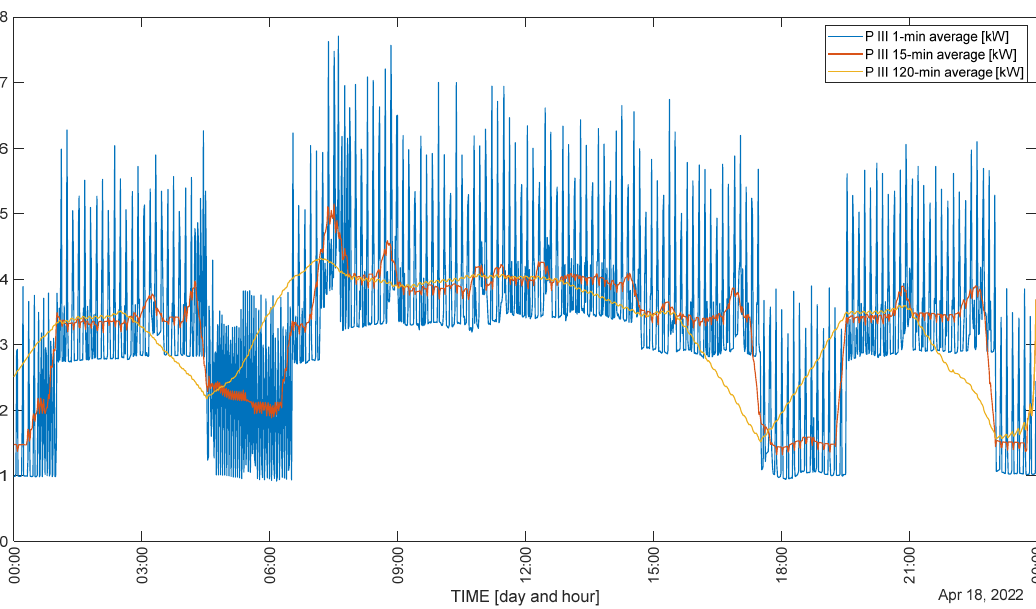
Figure 11. Three-phase active power as a function of time on a representative day of the 3rd stage.